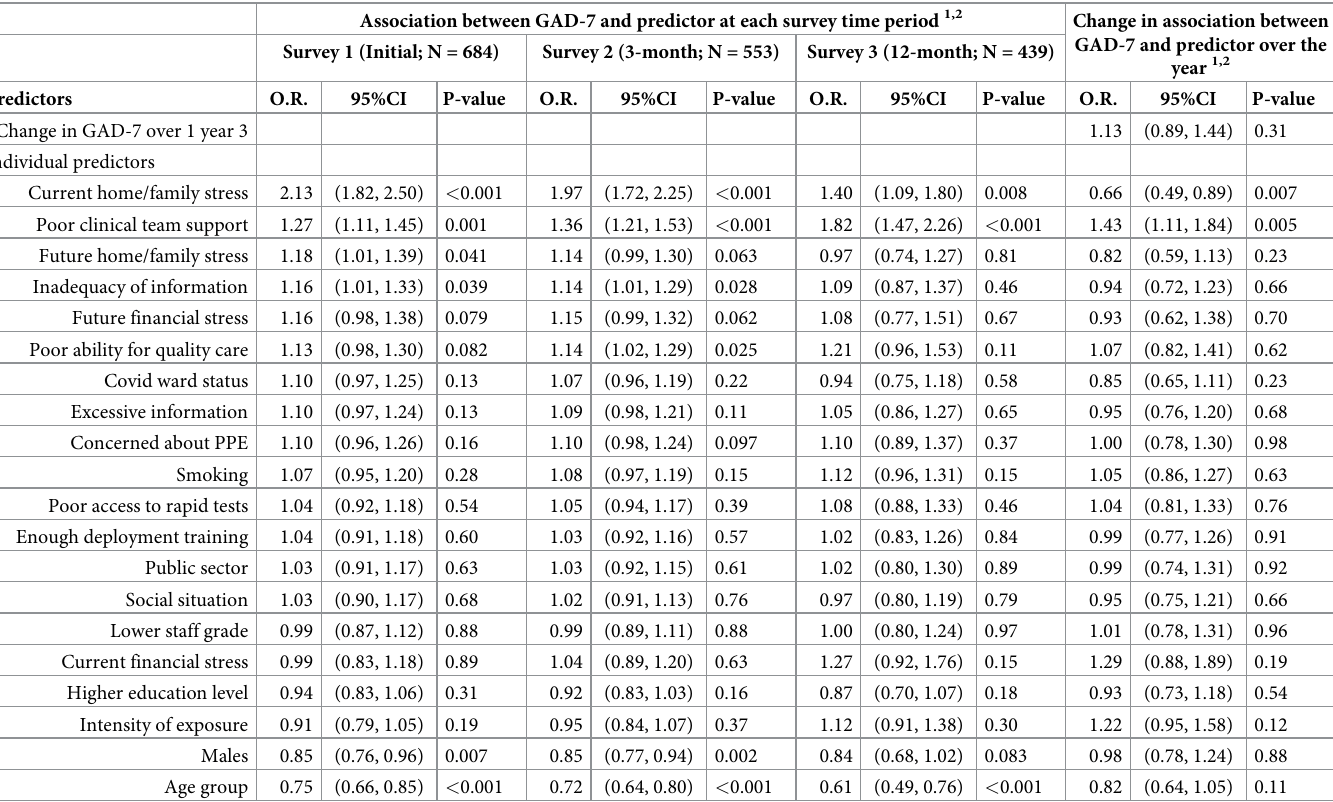
Table 3. Relative impact of predictors on Generalized Anxiety Disorder (GAD-7) score in responses over the year of surveys. Association between GAD-7 and predictor at each survey time period